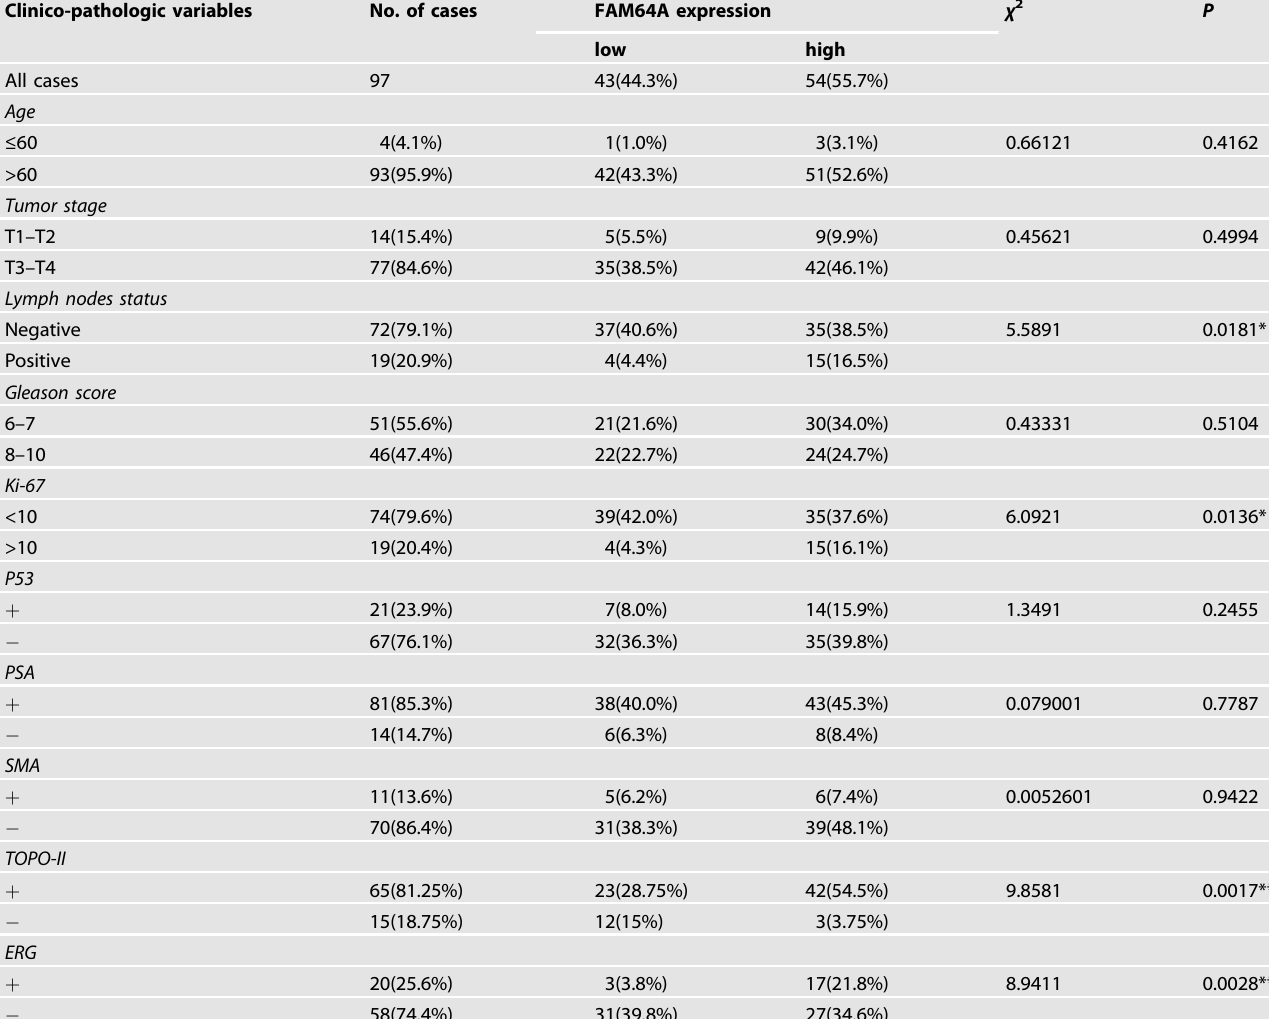
Table 3. Correlation between FAM64A expression and the clinicopathological characters of patients with PCa (IHC). Clinico-pathologic variables